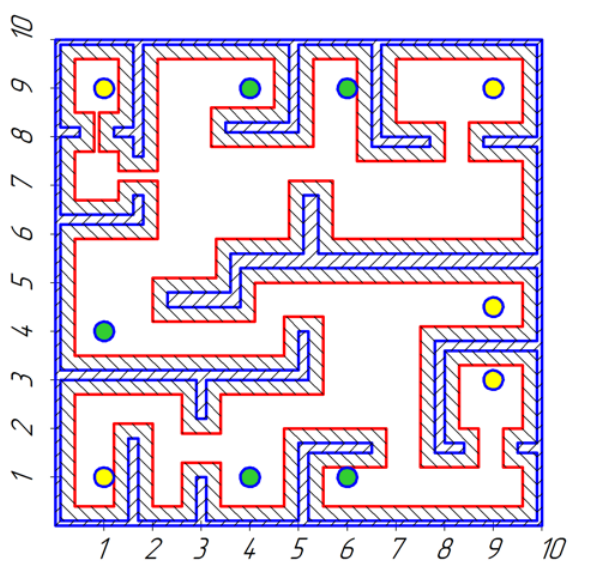
Fig. 5. An example of a group control task. The robot moves from yellow dots - base points, to green dots - target points; shaded area - impassable zone.